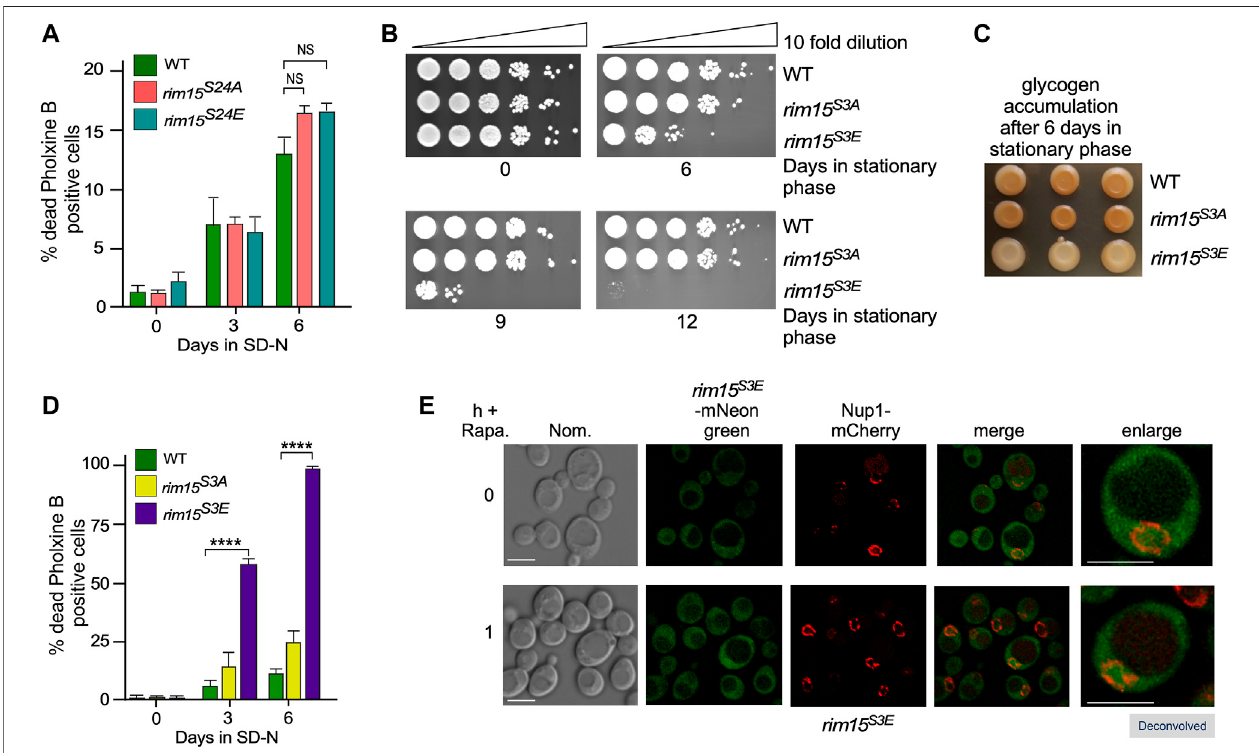
FIGURE6| Thephosphomimetic mutant, rim15 S3E (RSY2365), but not rim15 S24A (RSY2350) rim15 S3A (RSY2360), or rim15 S24E (RSY2341) phenocopies rim15 Δ . (A) and (D) Mid-log cells with the genotypes shown were washed then switched to SD-N medium. The percent of inviable cells within the population was determined using phloxine B staining and FACs analysis after 3 or 6 days. N = 3. NS p ≥ 0.05; **** p ≤ 0.001. (B) Quiescent survival assays for mid-log liquid YPD cultures of the indicated genotype kept in stationary phase for the number of days shown. Ten-fold serial dilutions of the cells were plated onto YPD plates and growth recorded after 48 h at 30 ° C. (C) As in B except that the cells were scored for glycogen accumulation using iodine stains. (E) Fluorescence microscopy of endogenous rim15 S3E - mNeonGreen (RSY2454) before and after the addition 200 ng/ml rapamycin. Representative deconvolved images are shown. Scale bar: 5 µm. Nom. — Nomarski